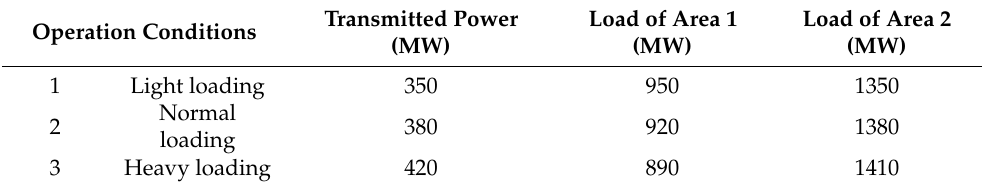
Table 2. The summary of operating conditions of IEEE 4-Machine Power System. Operation Conditions